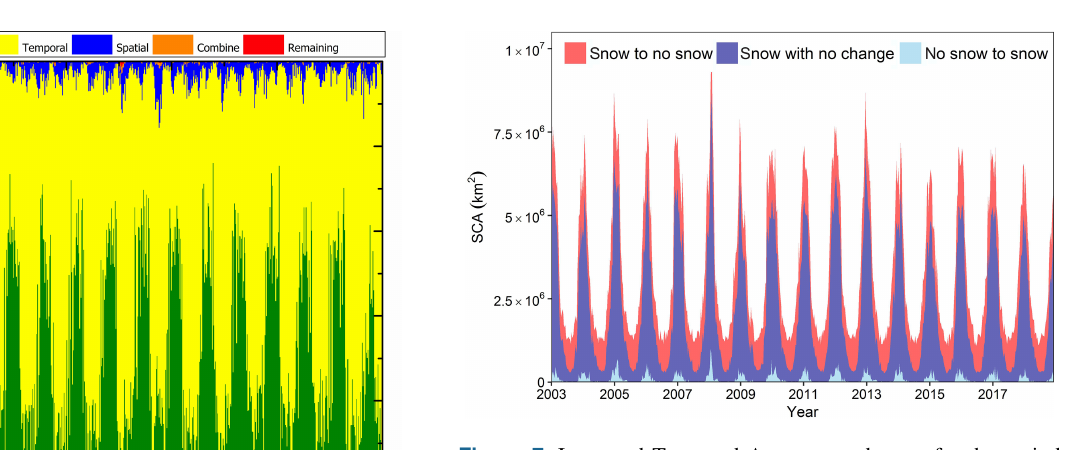
Figure 7. Improved Terra and Aqua merged snow for the period between 2002 and 2018. The value − 200 is the snow converted to no snow in the final product, 0 is no snow either in the C6 data or converted from cloudy pixels, 200 is snow without any change in the MOD10A2 and MYD10A2 C6 products and MOYDGL06* product, and 210 is the no snow converted to snow mainly due to cloud cover.